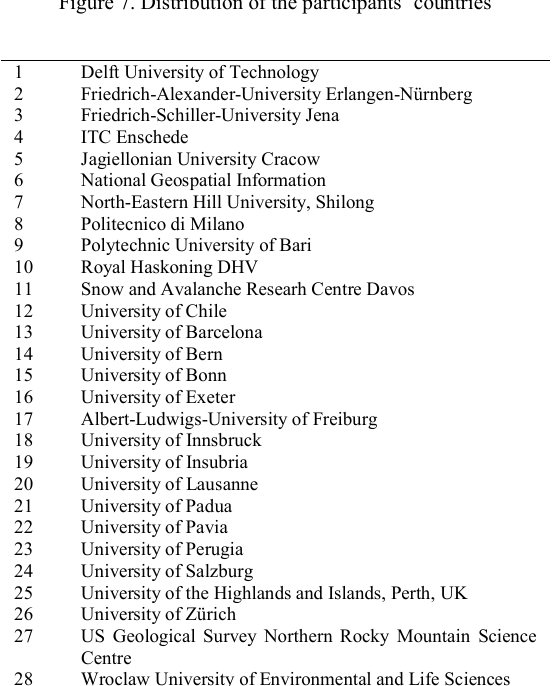
Figure 7. Distribution of the participants’ countries